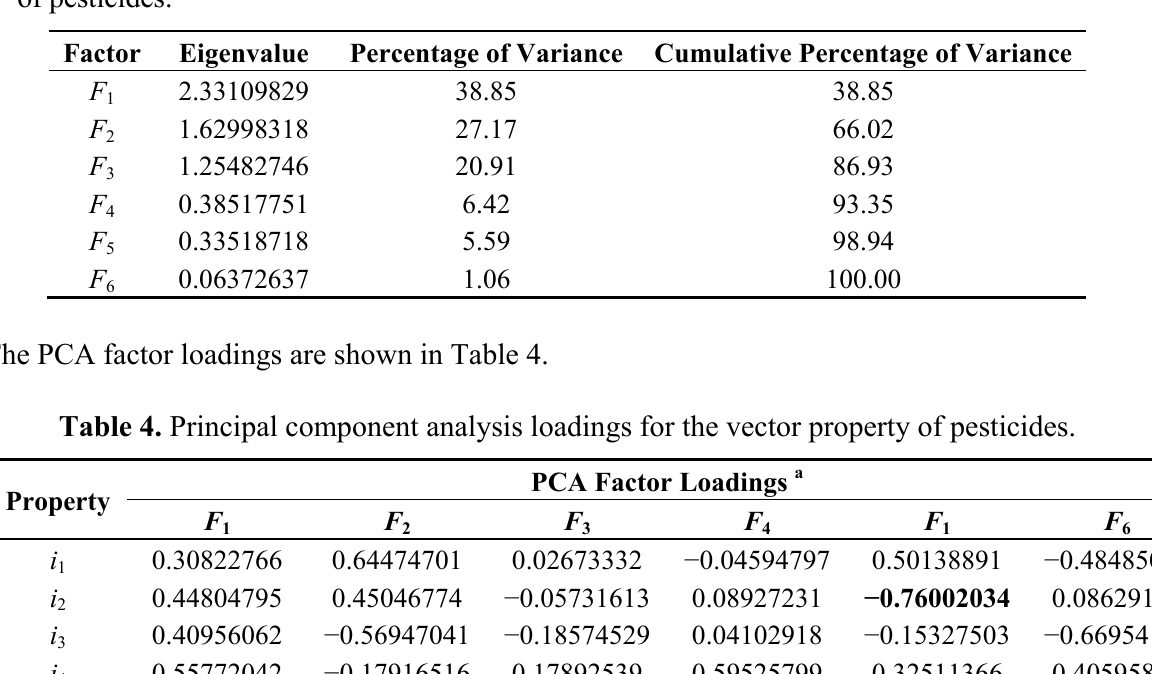
Table 3. Importance of the principal component analysis factors for vector property of pesticides.